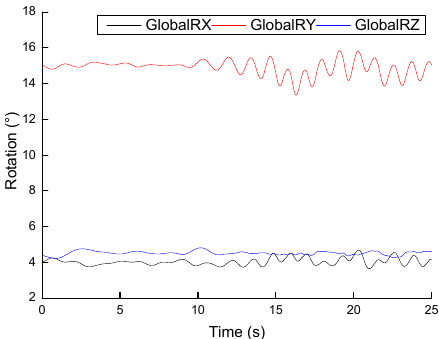
Figure 12. Test under the second working condition.